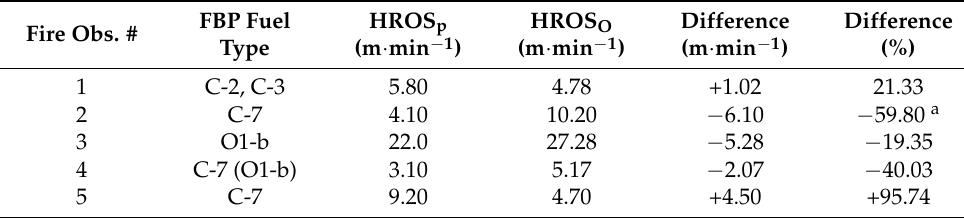
Table 6. The observed and FBP System predicted fire spread rates for the fire behaviour parameters from the georeferenced wildfire imagery. HROS p and HROS O refer to predicted and observed rate of spread. See the Appendix A for FBP System calculation